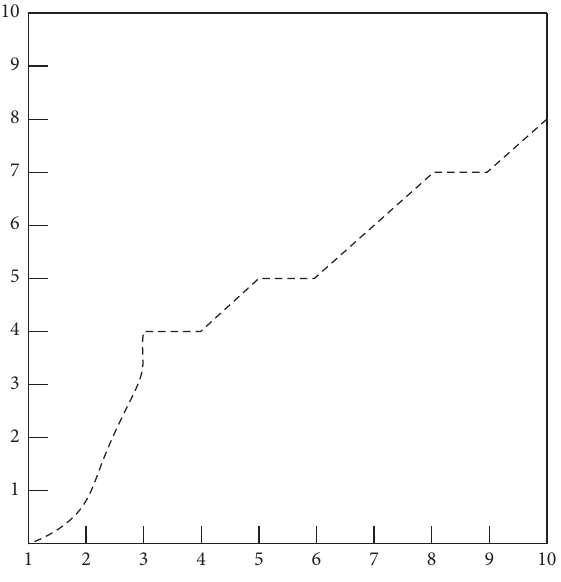
Figure 2: DTW algorithm path search